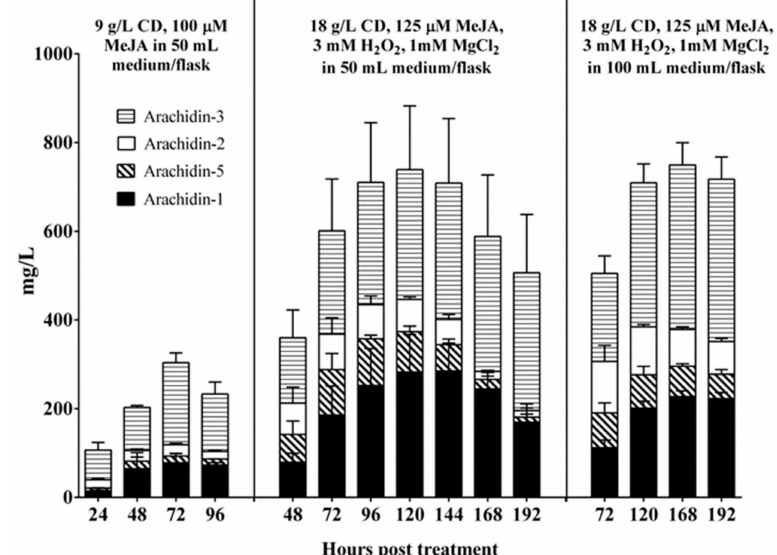
Figure 3. Time course of prenylated stilbenoid yield in the medium of peanut cv. Hull hairy roots of line 3 after treatment with optimized concentration of elicitors. Prenylated stilbenoids were extracted from the culture medium and quantified by HPLC. Yields are expressed in mg / L. Values are the average of three biological replicates and error bars represent standard